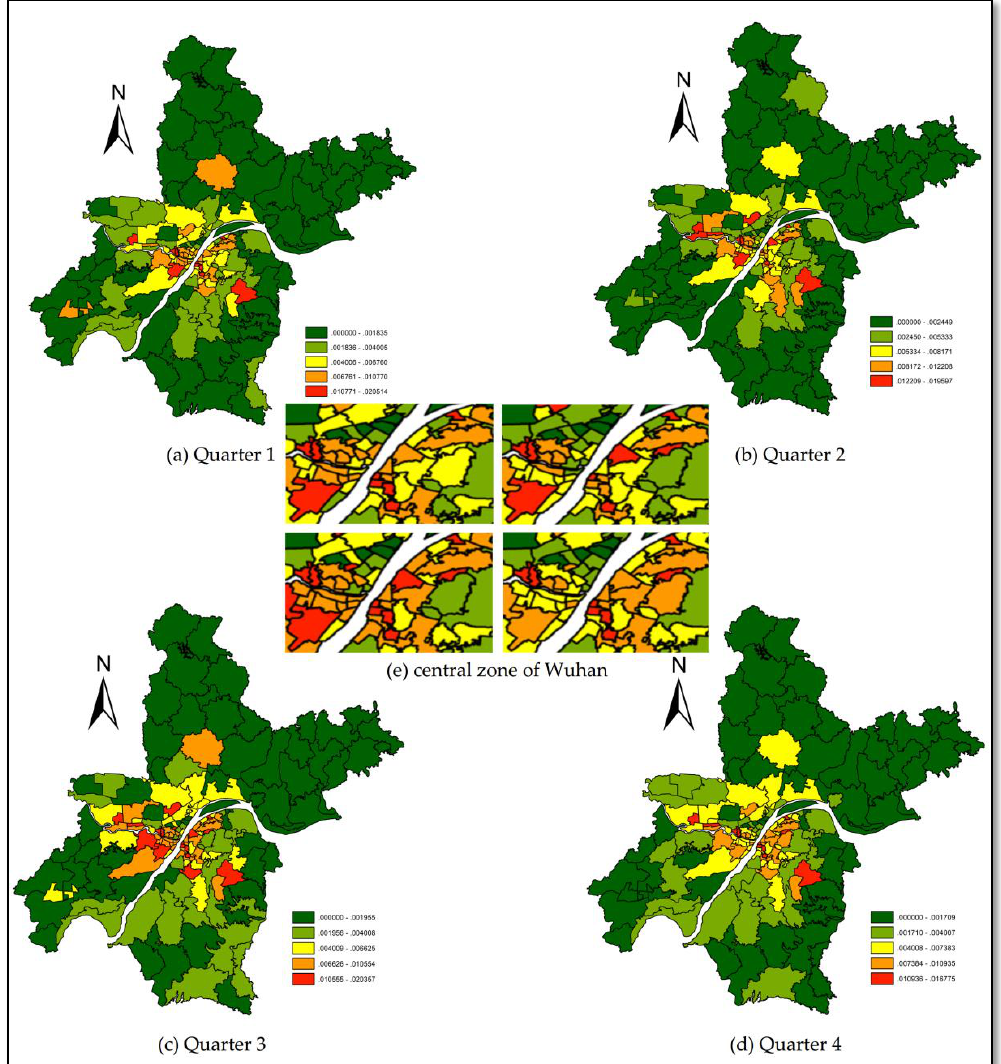
Figure 3. Distribution of theft rate incidents in Wuhan during the study period.